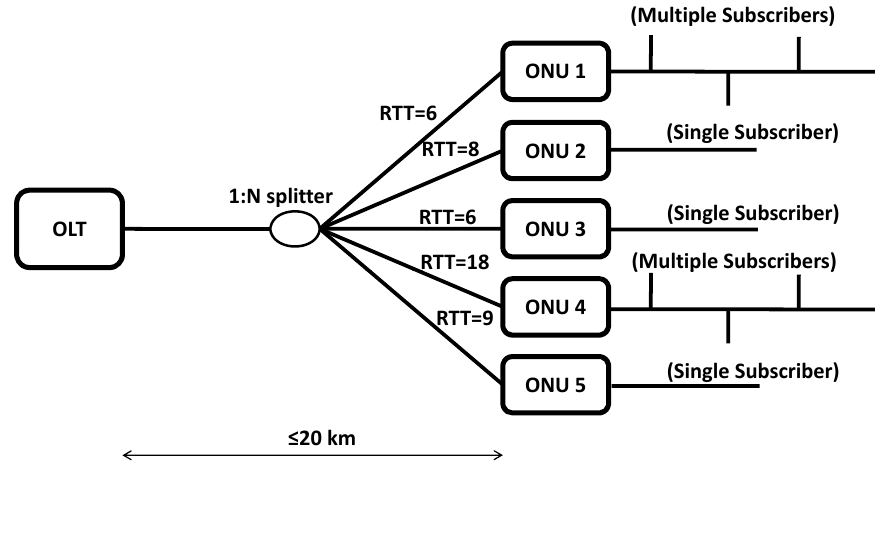
Figure 2. Network architecture of an EPON with one OLT and N = 5 ONUs, each with a different